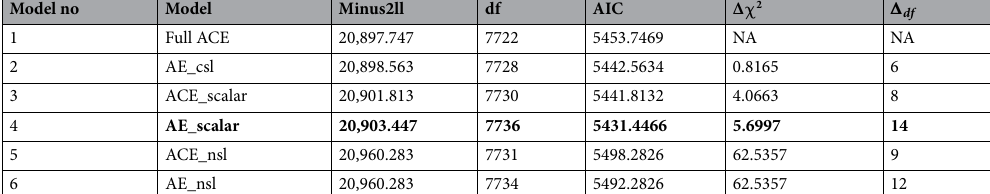
Table 3. Model-fitting results from the bivariate analyses. Best fitting model in bold type. Csl common sex limitations (allow for quantitative sex differences), scalar scalar sex limitations, nsl no sex limitations. Total N = 1987